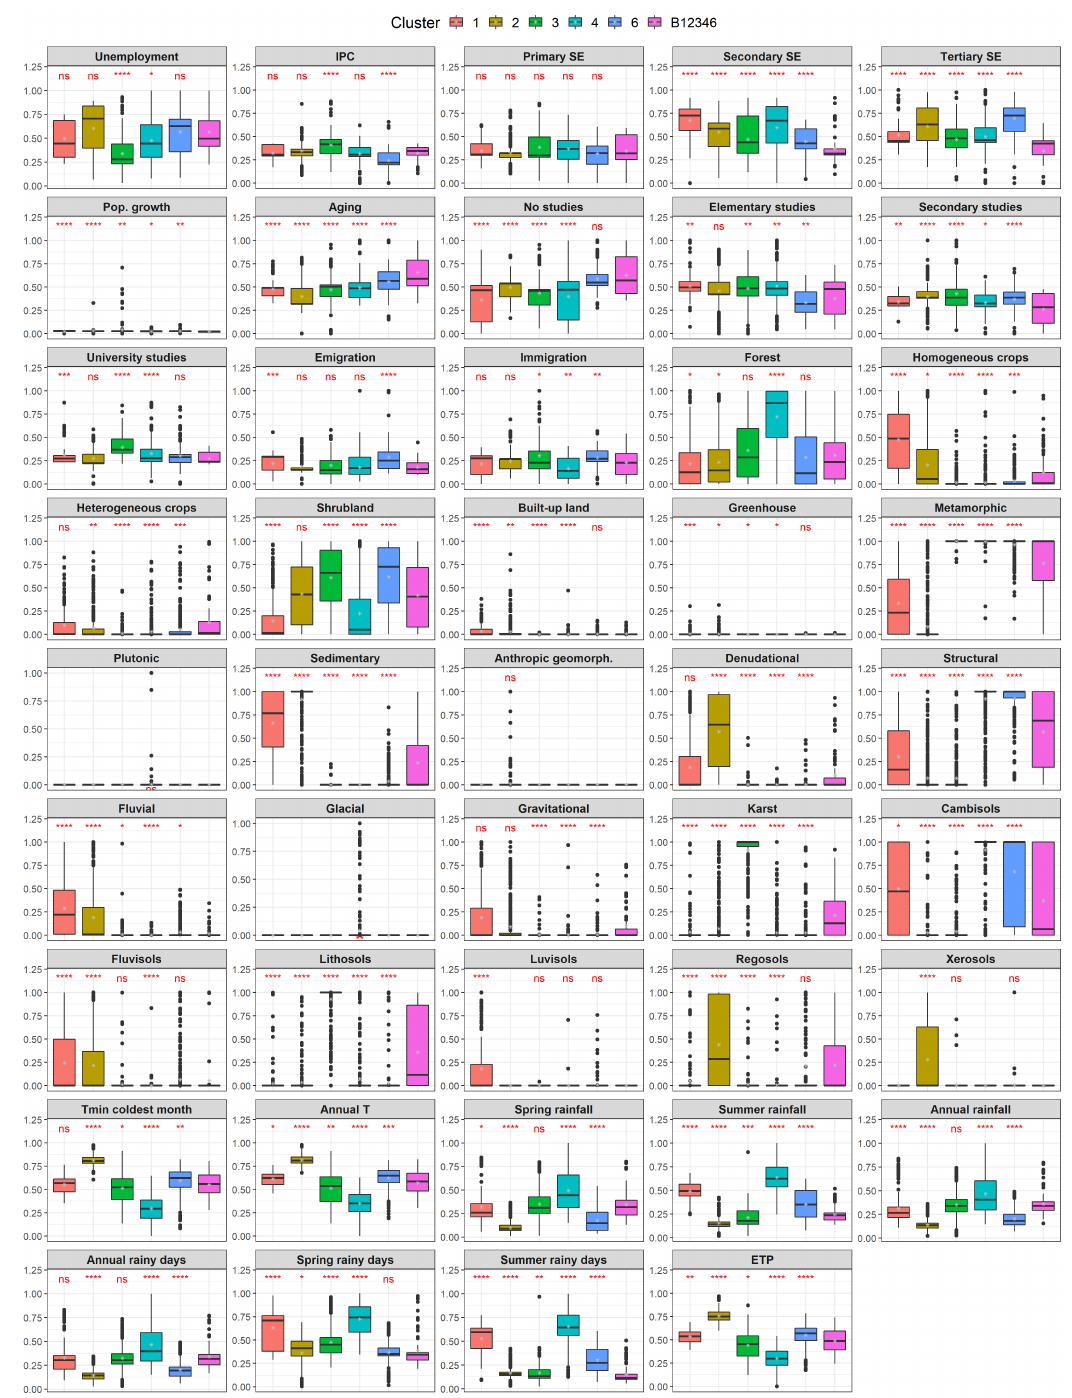
Figure A7. Comparison of the socio-ecological variables between sectors 1, 2, 3, 4 and 6 and the boundary among them (B12346). Statistical significance is shown as: ns: p -value > 0.05; *: p -value ≤ 0.05; **: p -value ≤ 0.01; ***: p -value ≤ 0.001; ****: p -value ≤